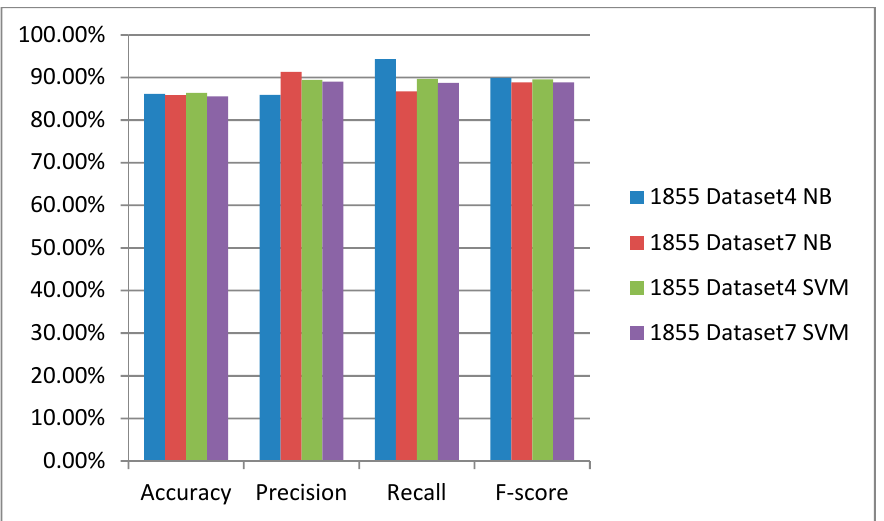
Figure 4. Graphical comparison of datasets 4 and 7 using Naïve Bayes and SVM on the 1855 Bordeaux Data.